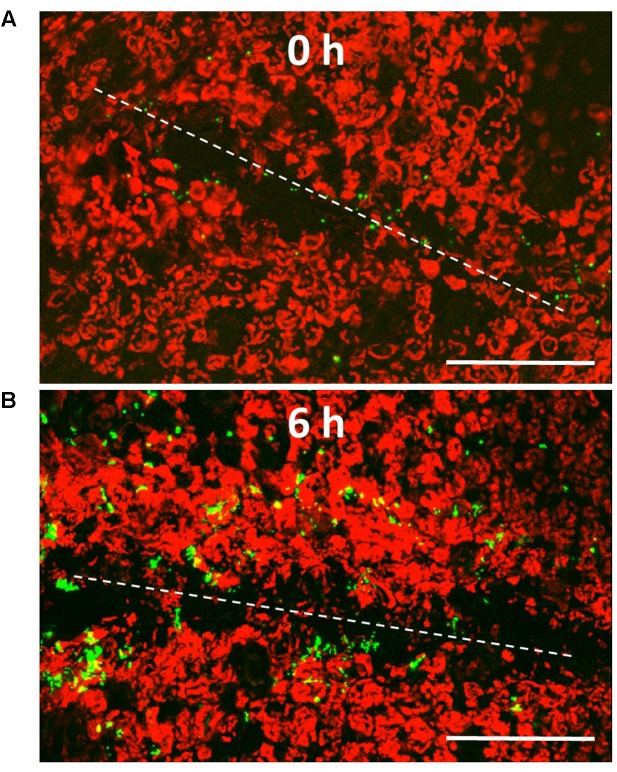
Pseudo-3D confocal scanning laser microscopy images of GFP-EcO157 in wounded lettuce leaf tissue. Green fluorescent EcO157 cells in the leaf wounds (A) immediately after inoculation by wounding (0 h), and (B) 6 h after inoculation and wounding. White dotted lines delineate the wound generated by a single forcep striation. The red signal originates from the autofluorescence of the chloroplasts present in the leaf cells. Scale bars: 100 μm.